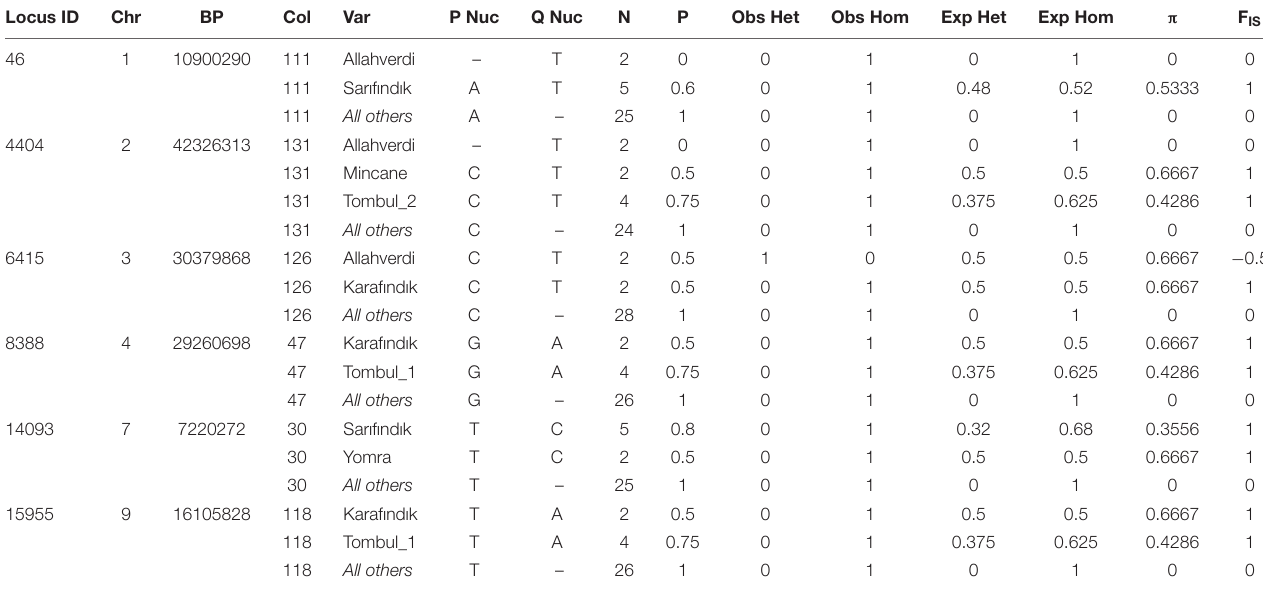
TABLE 4 | List of common alleles showing polymorphisms in specific